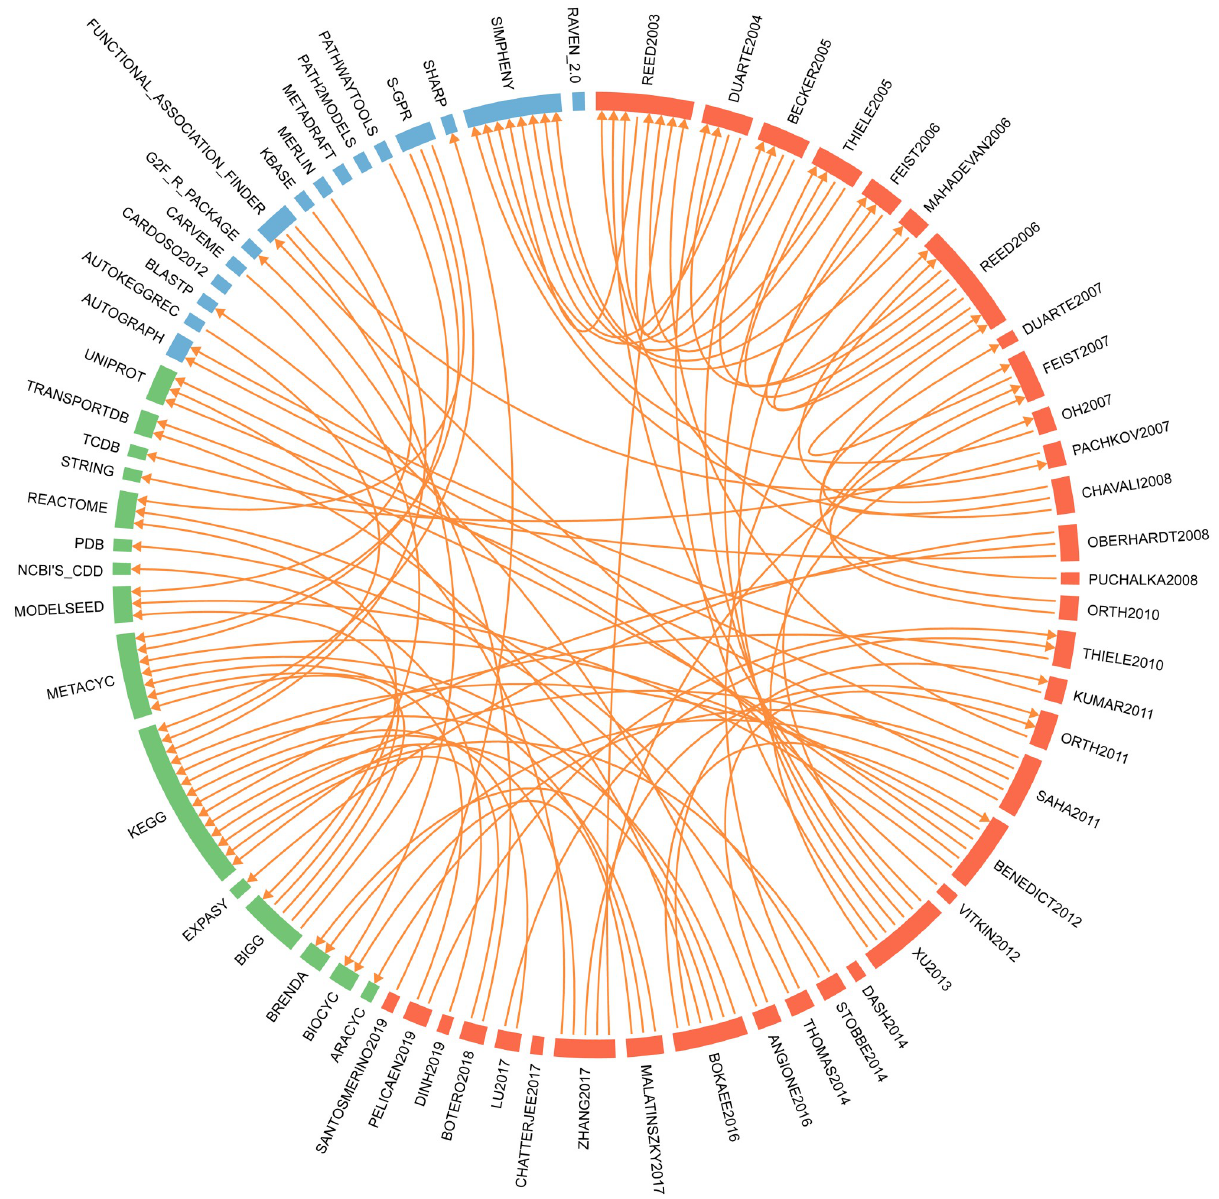
Fig 2. Literature analysis dealing with GPR reconstruction. In the circular plot, nodes correspond to the examined publications (red nodes), the adopted strategies (blue nodes) and data sources (green nodes). The nodes are ordered chronologically within the red category and alphabetically in the other two ones. Directed edges connect a given node to the to the exploited sources. If the source is not mentioned, the node remains isolated. Rectangles identify through their size the citation status of the corresponding node. References associated to each label are reported in the S1